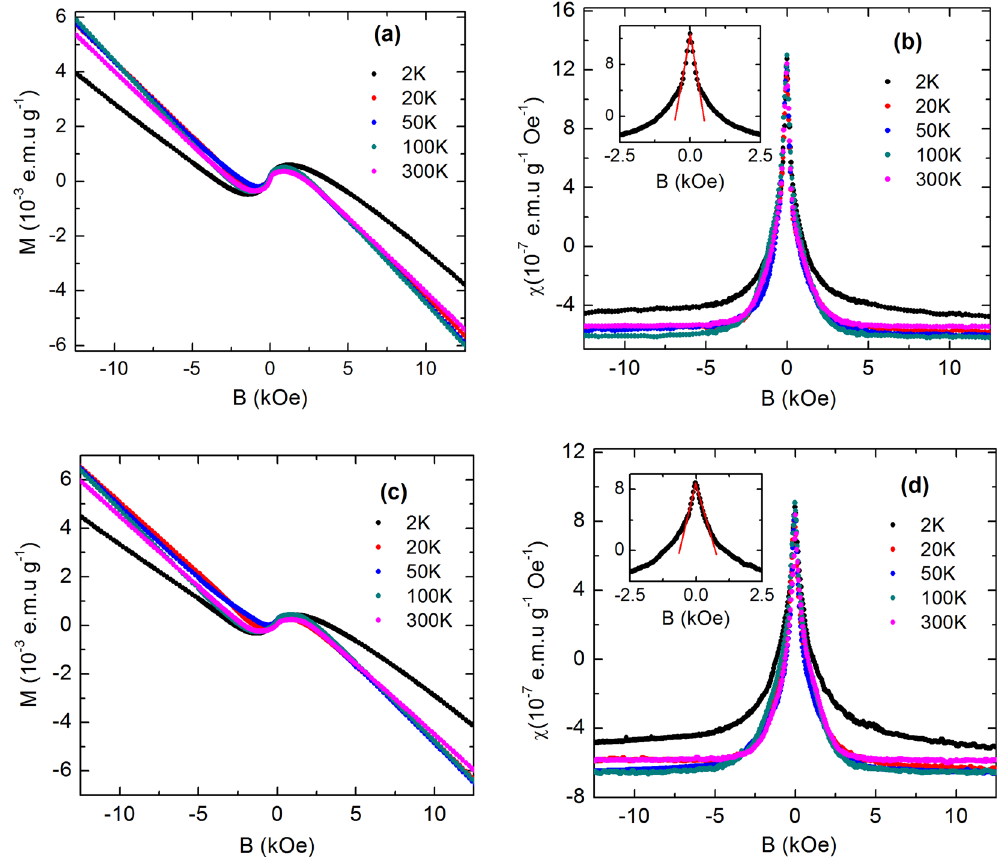
Figure 4. ( a ) Magnetization ( M ) versus B for the freshly cleaved single crystal (S2) of Bi 1.5 Sb 0.5 Te 1.7 Se 1.3 at several representative temperatures from 2 to 300 K, ( b ) Susceptibility χ = ( ) dM by taking the first-order derivative of magnetization. Inset shows the linear-in-field decay of χ from its